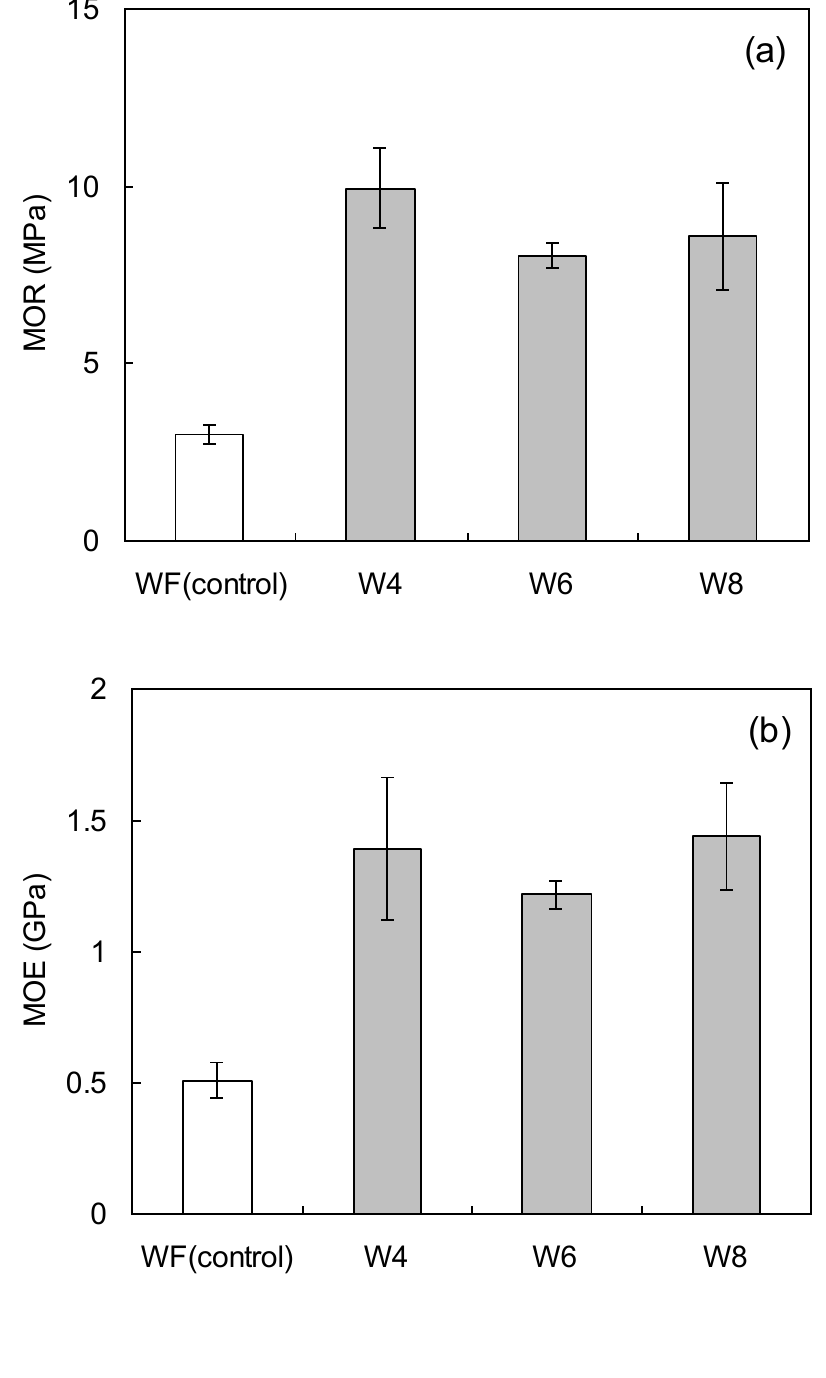
Figure 3. The bending properties, ( a ) MOR and ( b ) MOE, are given for 85:15 wood flour:LCNF boards as a function of pulverization setting. The vertical bars indicate a single standard deviation. WF: wood